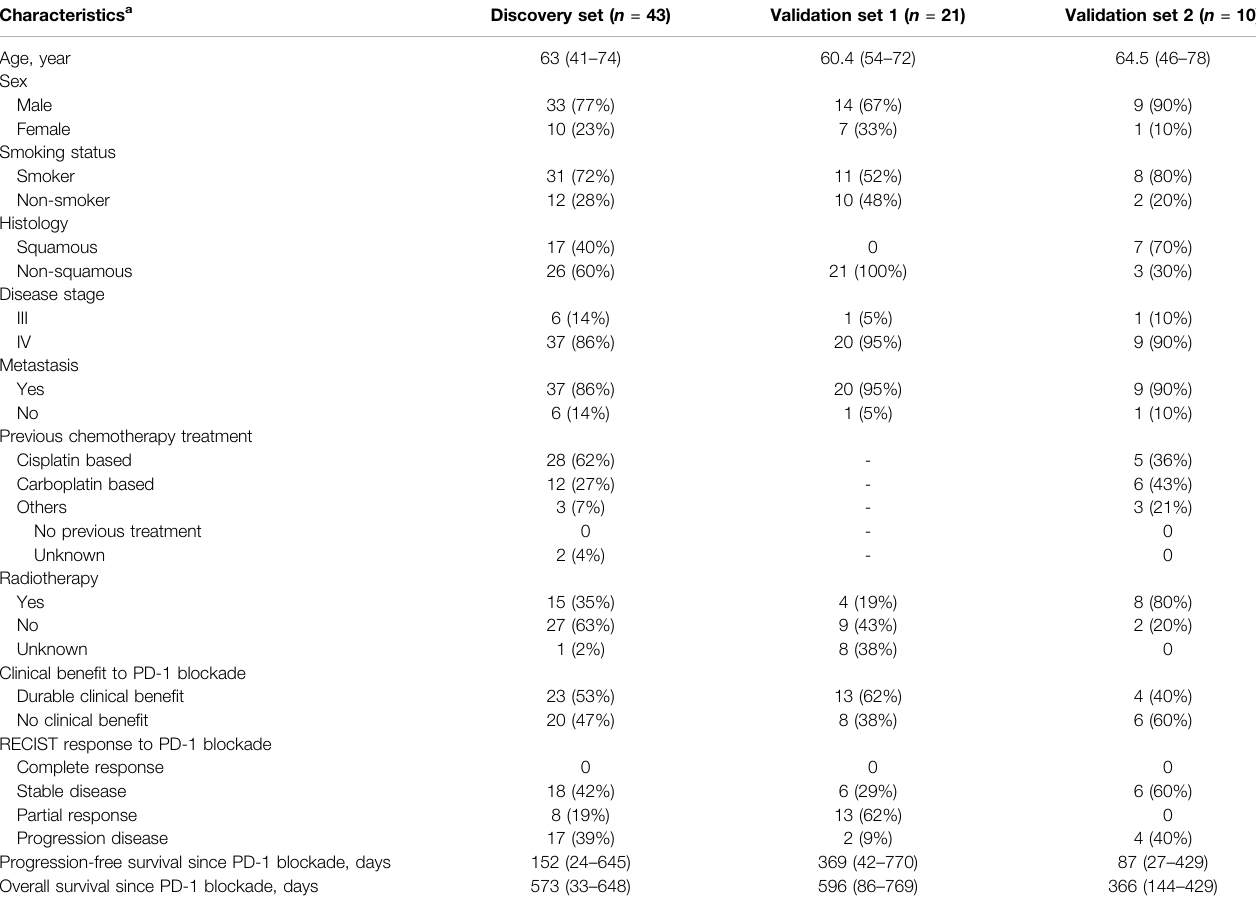
TABLE 1 | Clinical characteristics of discovery and validation sets and ef fi cacy of anti-PD-1 therapy. Characteristics